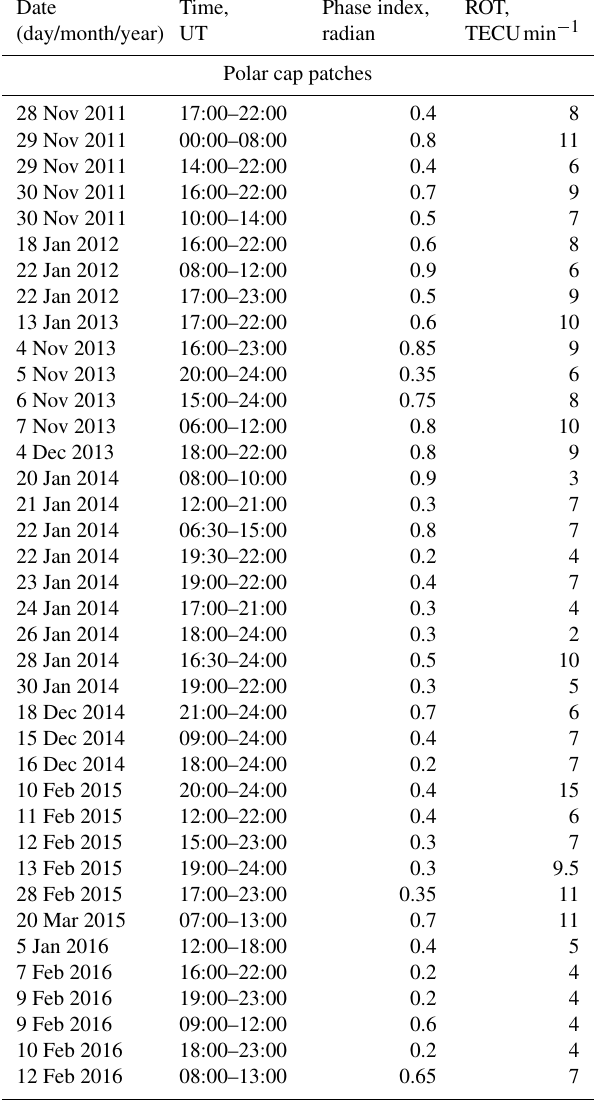
Table 4. The values of the phase scintillation index and ROT, deter- mined from the GPS receiver at NYA station, during PCPs